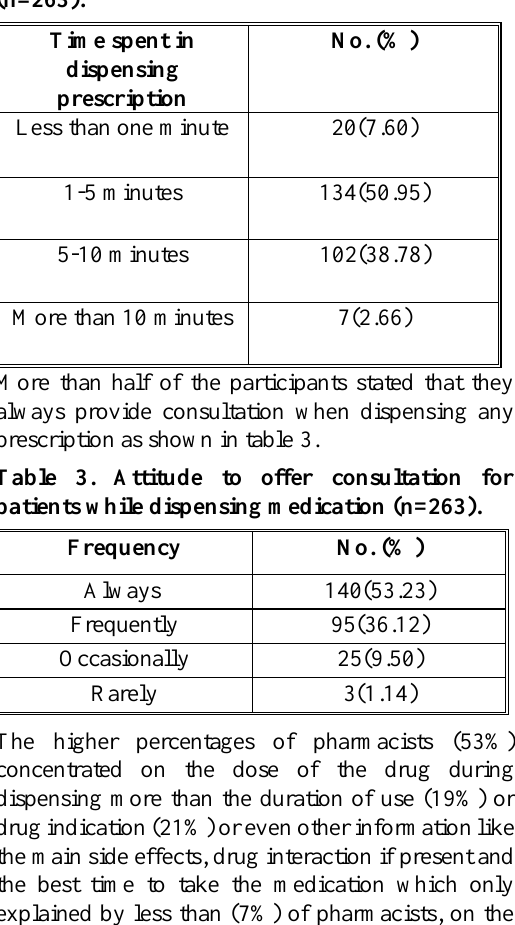
Table 2. Time required to dispense a prescription